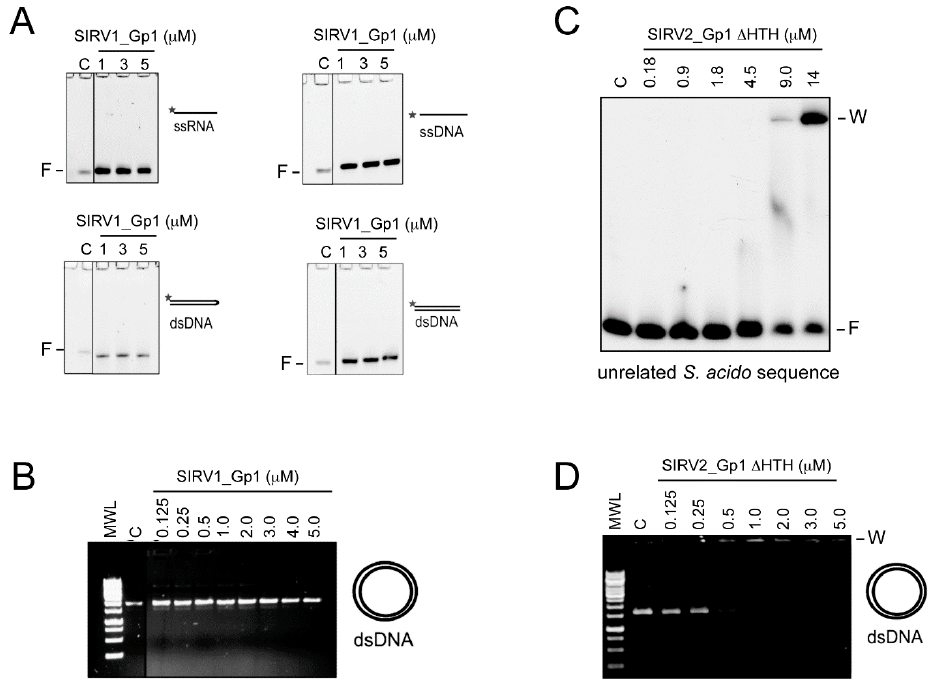
Figure 4. Nucleic ‐ acid binding assays of SIRV1_Gp1 and SIRV2_Gp1 ∆ HTH proteins. ( A ) Fluorescence imaging of nucleo ‐ protein adduct formation with SIRV1_Gp1 with short randomized probes. C indicates the control reaction without any protein. ( B ) EMSA of SIRV1_Gp1 with plasmid DNA visualized by UV imaging of an ethidium bromide ‐ stained 1% agarose gel. ( C ) EMSA of SIRV2_Gp1 ∆ HTH with plasmid DNA visualized by UV imaging of an ethidium bromide ‐ stained 1% agarose gel. ( D ) EMSA of SIRV2_Gp1 ∆ HTH with a short 32 P ‐ labeled probe representing an unrelated promoter sequence of Sulfolobus acidocaldarius . Binding reactions were performed in presence of unlabeled competitor DNA. F, free probe; W, wells.